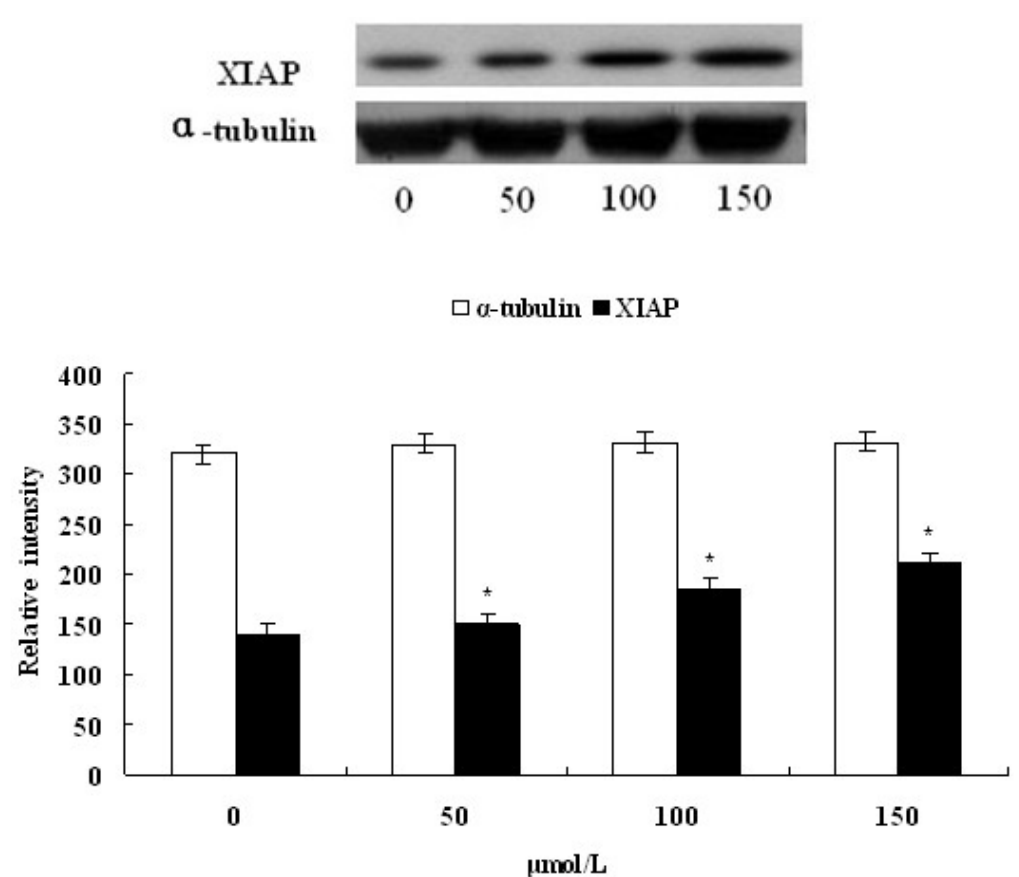
Figure 5. Effects of 1-(4-methylpent-2-enyl)-2-(4-phenylbut-2-enyl)disulfane on the protein expressions by Western